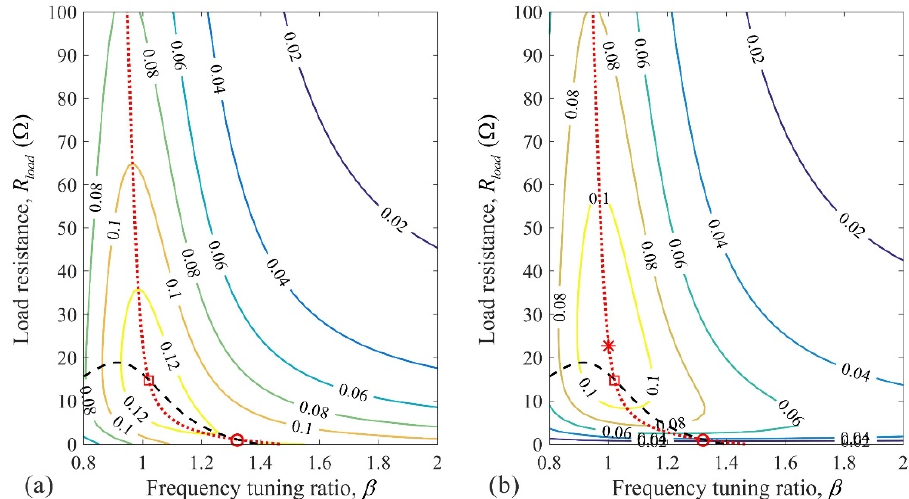
Figure 6. Contour plots of I 2 ( a ) and I 3 ( b ) superimposed with Equation (30)’s solution (black dashed line) and Equation (31)’s solution (red dotted line) when µ = 0.05 and ζ p = 0.05.